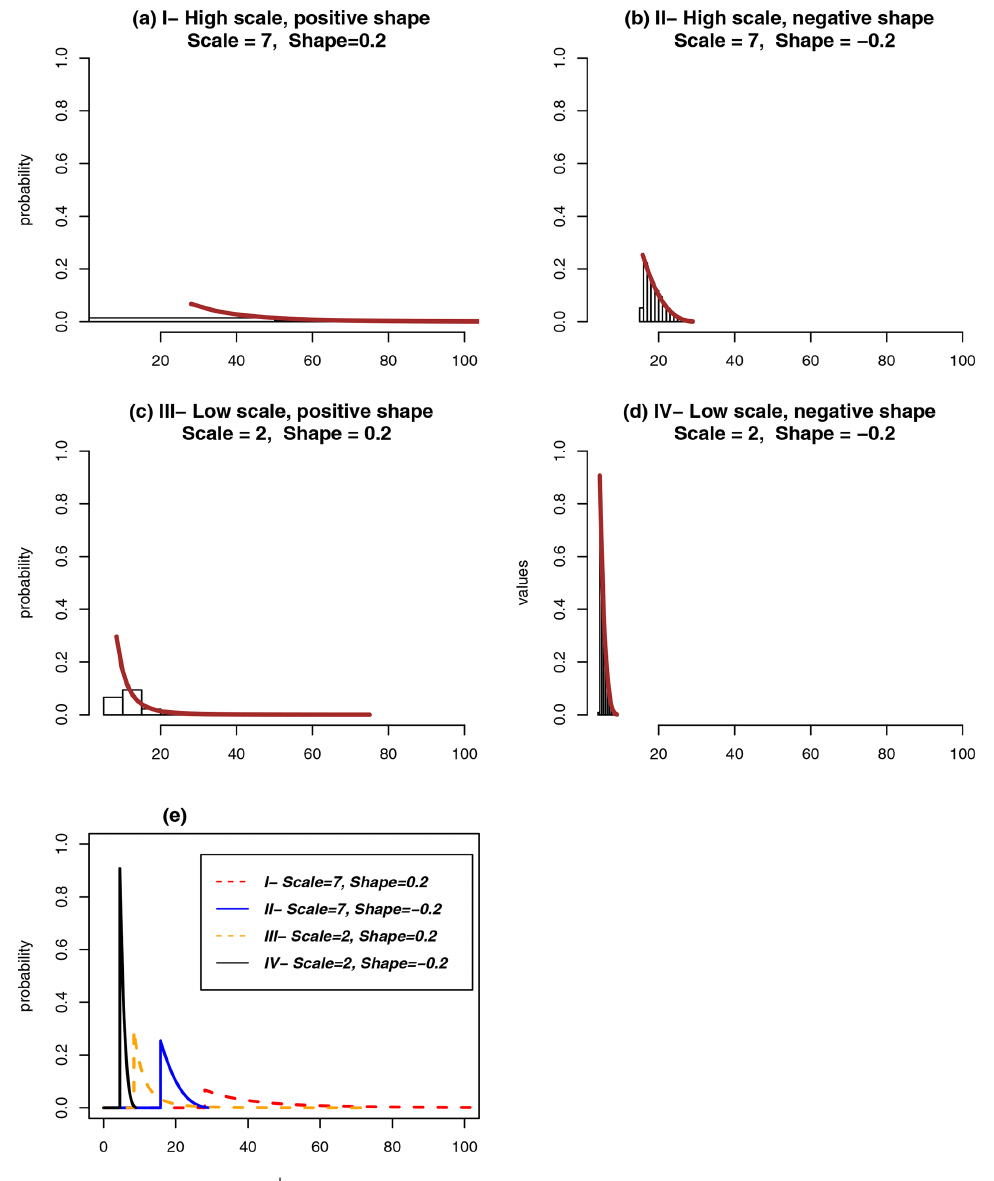
Figure 2. (a–d) Probability density distributions of extremes of a variable with different scale and shape parameters. (e) All distribution functions